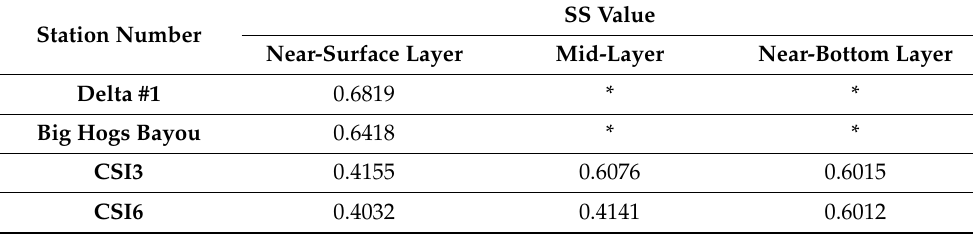
Table 3. Skill score (SS) value of current velocity for 4 stations (* indicates not available or applicable).